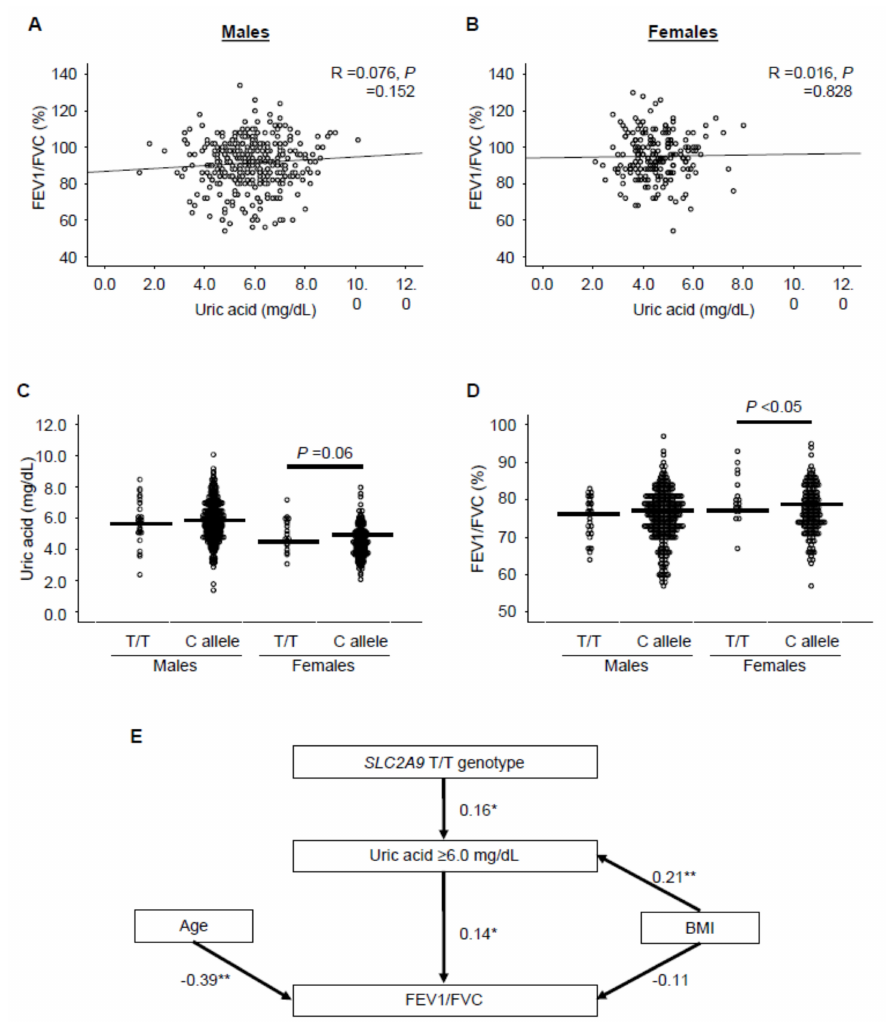
Figure 5. The possible association between uric acid and lung function in humans. ( A,B ) The correlations between UA and FEV1 / FVC in males ( A ) and females ( B ). Correlation coe ffi cients (r) and p -values were calculated by Pearson’s correlation test. ( C,D ) The association of the SLC2A9 / GLUT9 genotype with uric acid ( C ) or FEV1 / FVC ( D ) in males and females. P values were calculated by the Mann–Whitney U test. ( E ) Structural equation modeling diagram of respiratory function and uric acid levels in females. Lines with numbers indicate significant paths with standardized partial regression coe ffi cients (* p < 0.05, ** p < 0.01). Arrows represent an association between two factors. The β values ranged from –1 to 1, with a positive value representing a positive correlation and a negative value representing a negative correlation. B: standardized partial regression coe ffi cient; BMI: body mass index; FEV1: forced expiratory volume in 1 second; FVC: percent predicted forced vital capacity; SLC2A9 / GLUT9: solute carrier family 2 member